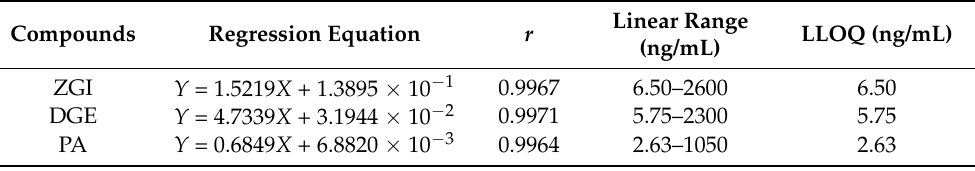
Table 1. The regression equations, linear ranges, and LLOQ for the determination of analytes in rat plasma ( n = 6).